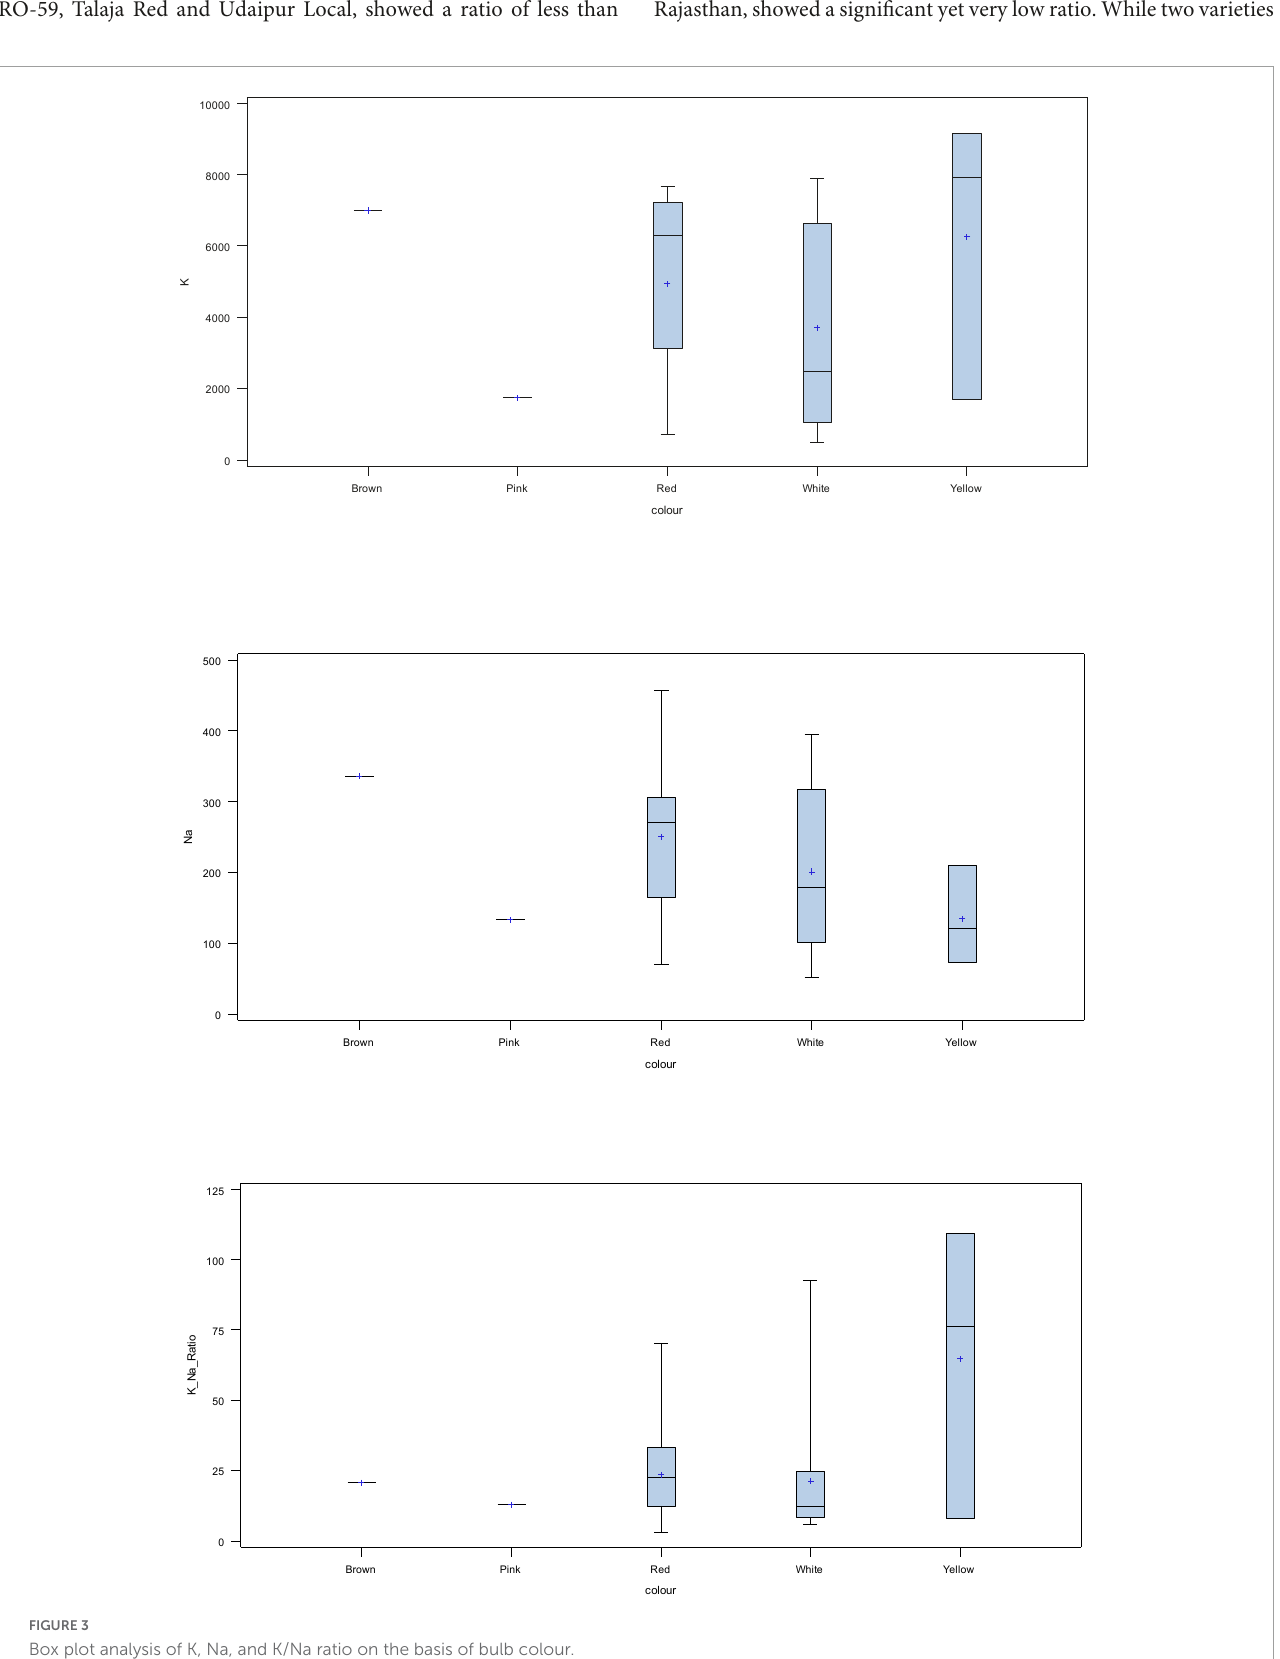
FIGURE3 Box plot analysis of K, Na, and K/Na ratio on the basis of bulb